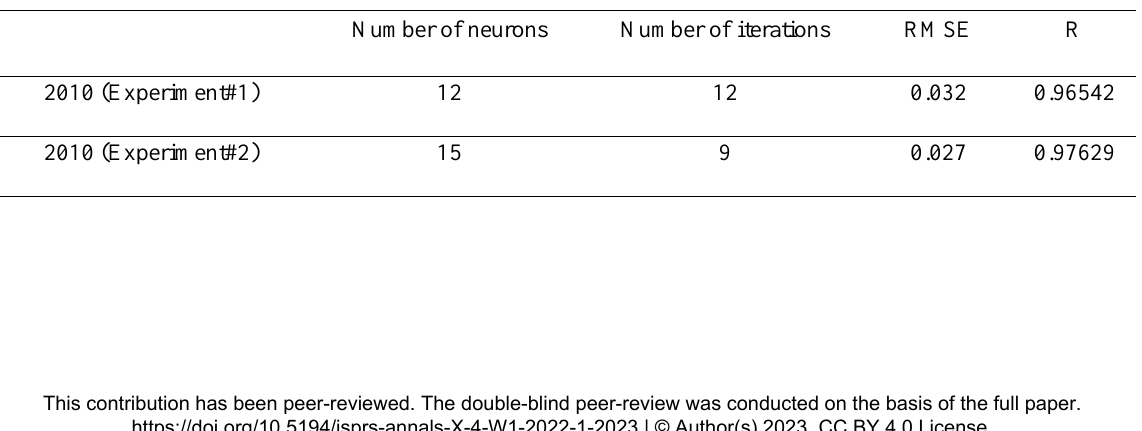
Table 1. The R and RMSE of time series